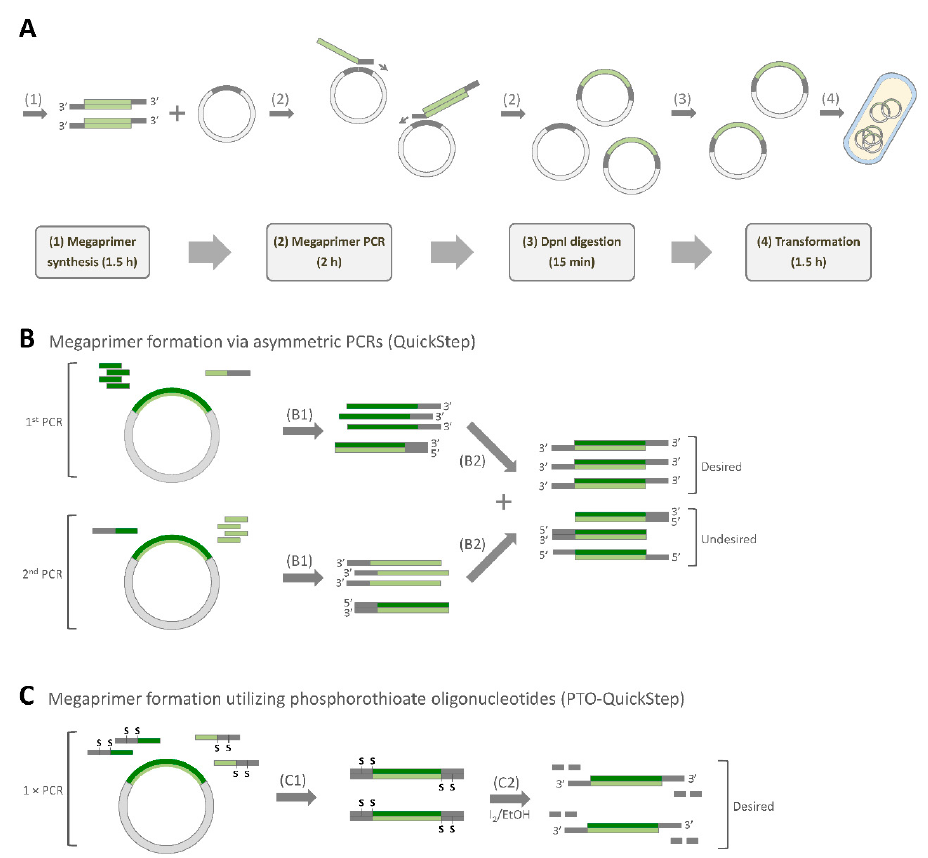
Figure 1. Overview of QuickStep and PTO-QuickStep. ( A ) Major steps of the method and estimated durations when cloning a 1 kb insert into a 7 kb recipient plasmid (adapted from [6,7]). ( B ) Molecular mechanism of megaprimer synthesis via two parallel asymmetric PCRs, featured in the original QuickStep method (B1: two asymmetric PCRs, B2: PCR purification and mixing of the products of the two asymmetric PCRs). ( C ) Molecular mechanism of megaprimer synthesis utilizing phosphorothioate (PTO) oligonucleotides, featured in PTO-QuickStep (C1: a standard PCR with PTO oligos, C2: iodine cleavage of PTO bonds via 5 min incubation in alkaline iodine solution. The short strands of DNA produced during the cleavage reaction are removed in a subsequent PCR